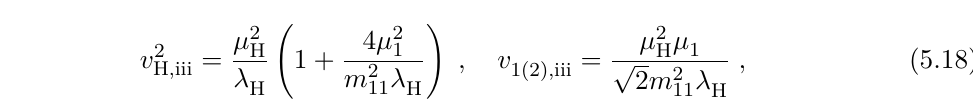
with respect to v , v and v in four different case with typical Figure 3 . The distributions of V 1 2 soft H parameters. Top-left panel: µ 2 = 1 . 99 , m 2 = 0 . 33 , λ = 5 . 48 , λ = 5 . 48 , λ = − 6 . 03 , µ 11 1 14 H H = 1 . 41 , m 2 = − 1 . 49 , λ = 4 . 12 , λ = 4 . 12 , λ = 1 . 65 , µ = 0 . 07 ; Bottom-left Top-right panel: µ 2 11 1 14 1 H H = 0 . 90 , m 2 = 0 . 90 , λ = 0 . 90 , λ = 0 . 90 , λ = − 0 . 68 , µ = 0 . 05 ; Bottom-right panel: panel: µ 2 11 1 14 1 H H = 0 . 90 , m 2 = − 0 . 90 , λ = 0 . 90 , λ = 1 . 49 , λ = 2 . 09 , µ = 0 . 05 . All the mass-dimensional µ 2 11 1 14 1 H H parameters have been properly normalized to be